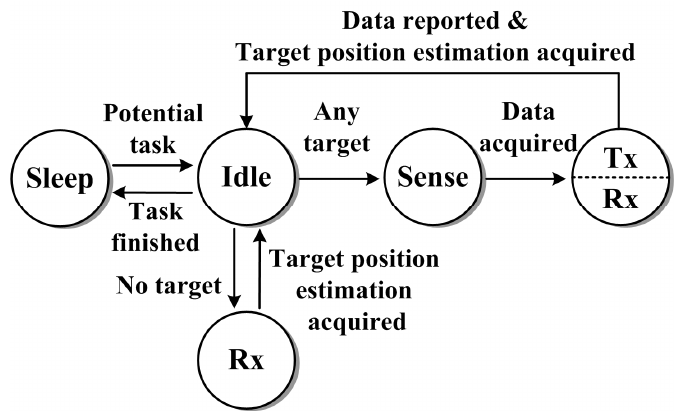
Figure 6. Operation mode transition in distributed sensor node awakening approach according to the forecasted target